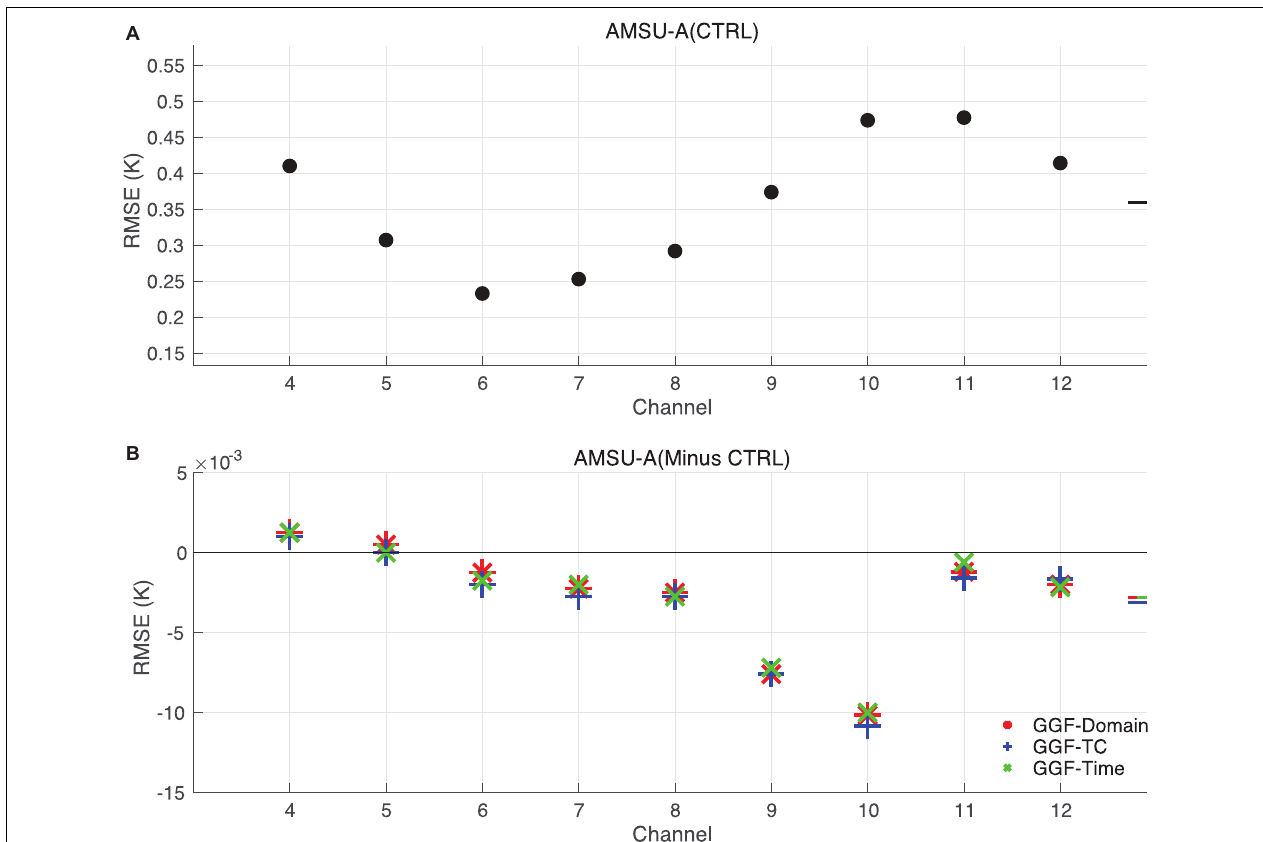
FIGURE 5 | Verified relative to the AMSU-A radiances, (A) RMSEs of 6-h priors of experiment CTRL, and (B) error differences between the GGF experiments and experiment CTRL. The bars on right denote the channel average values.